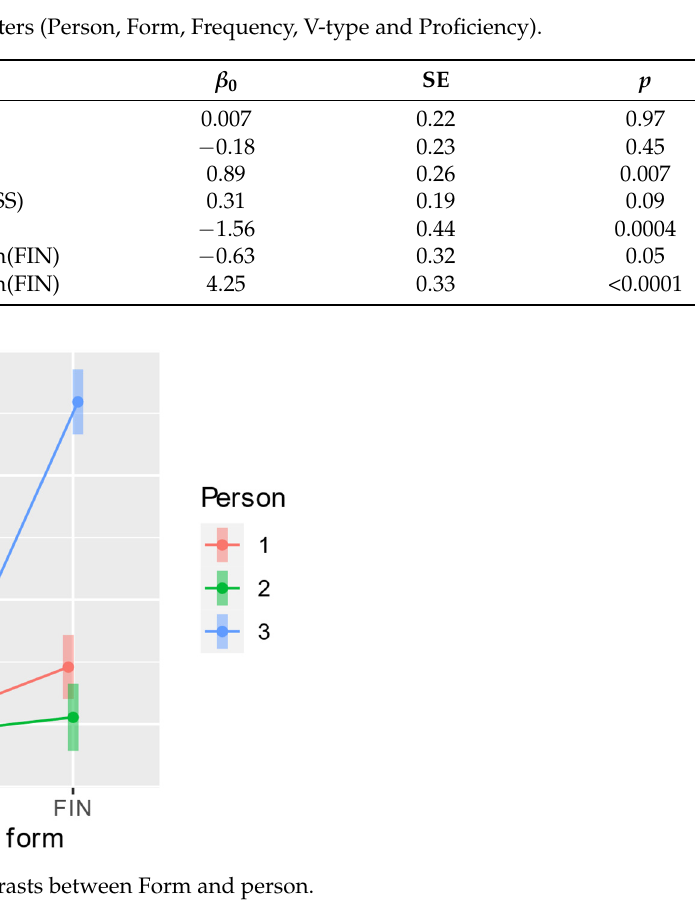
Figure 4. Pairwise contrasts between Form and